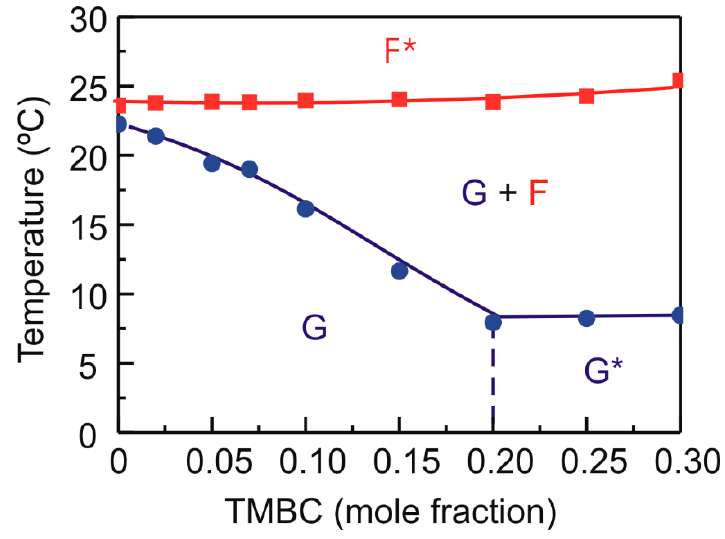
Figure 5. Partial phase diagram for DMPG in DMPG/TMBC mixtures. Circles and squares were obtained from the onset and completion temperatures of the main gel to liquid-crystalline phase transition, respectively. Blue circles, solidus line; red squares, fluidus line. The phase designations are as follows: G, gel phase; F, liquid-crystalline phase (fluid phase); asterisk indicates that immiscible phases are present.